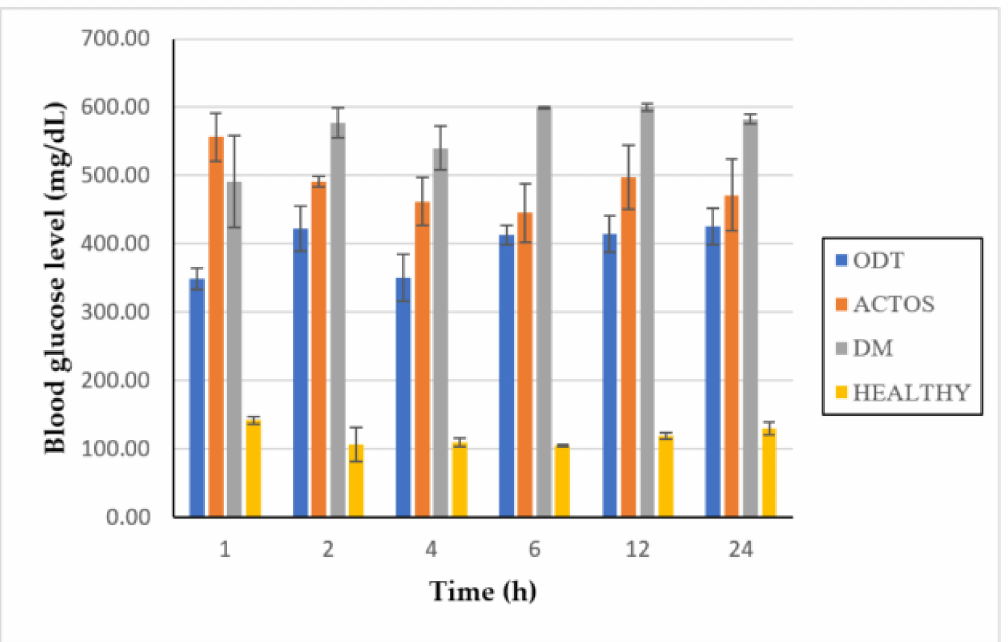
Figure 11. Graphical representation of the blood glucose levels in the 4 groups of rats (ODT, ACTOS ® (Commercial tablet), DM and Healthy) at time intervals of 1, 2, 4, 6, 12 and 24 h. Abbreviations: ODT, oral disintegrating tablet; DM, diabetic rats.